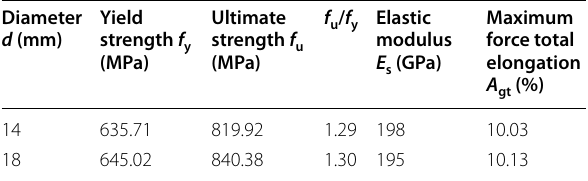
Table 4 Experimental mechanical properties of 600 MPa steel